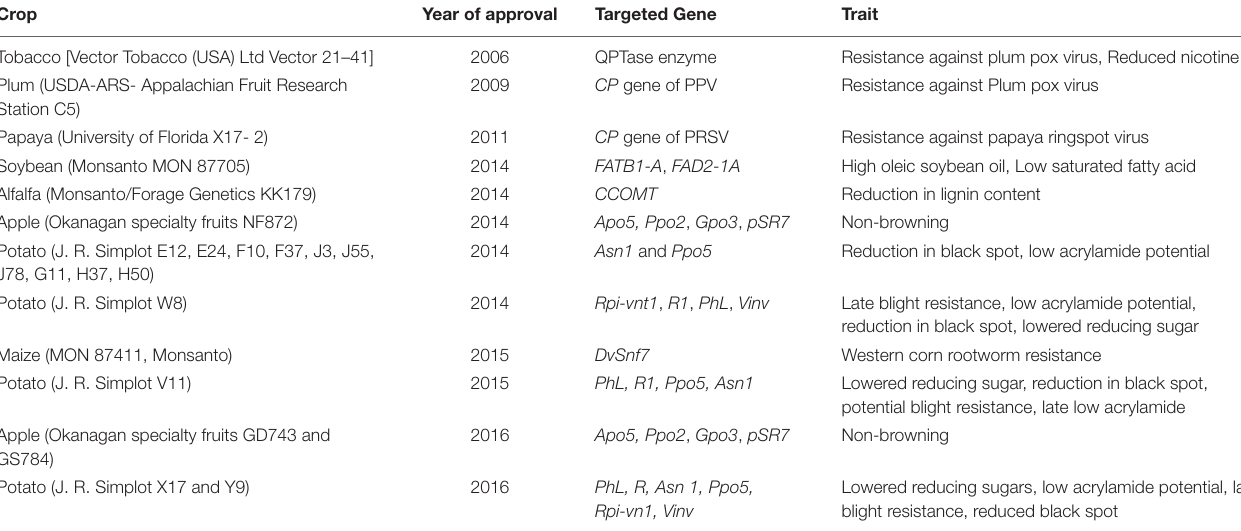
TABLE 5 | List of RNAi crops commercialized successfully (till 2021). Crop Year of